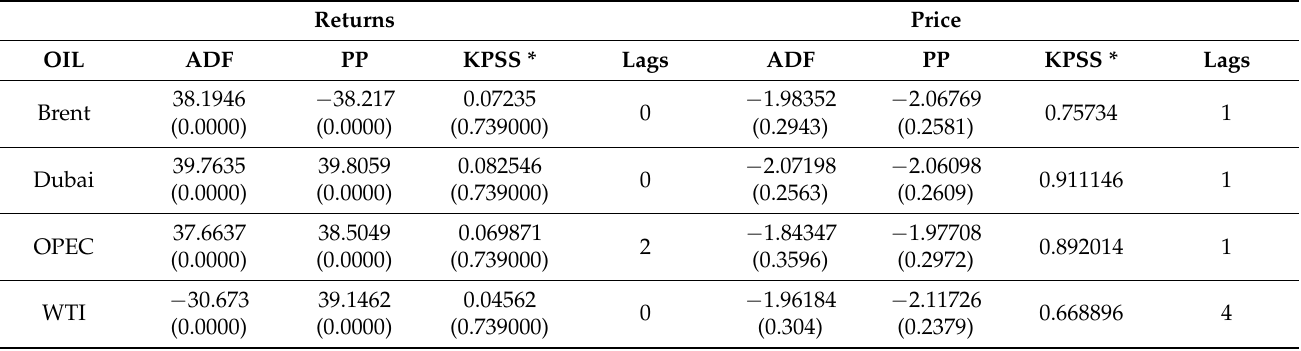
Table 8. Oil benchmarks Unit Root